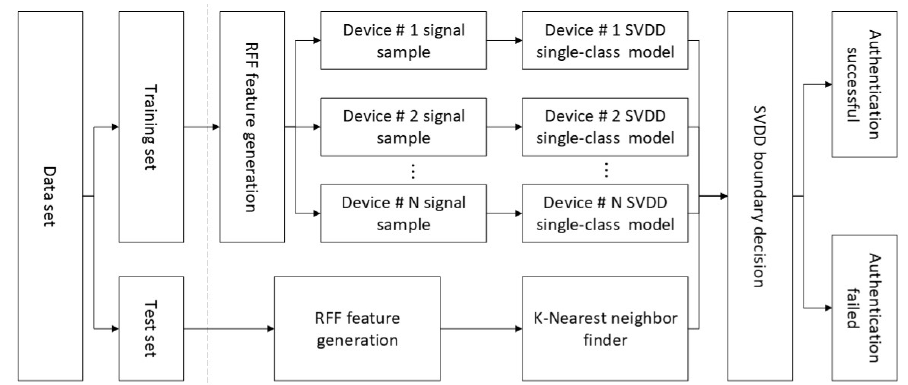
Figure 7. The specific form of the RFF authentication model. Support vector data description